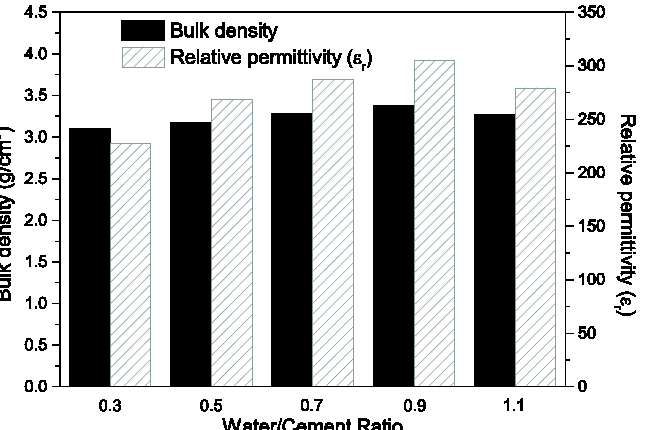
Figure 4. Variation of density and relative permittivity ( ε r ) of PZT–PC composites with different water/cement ratios.